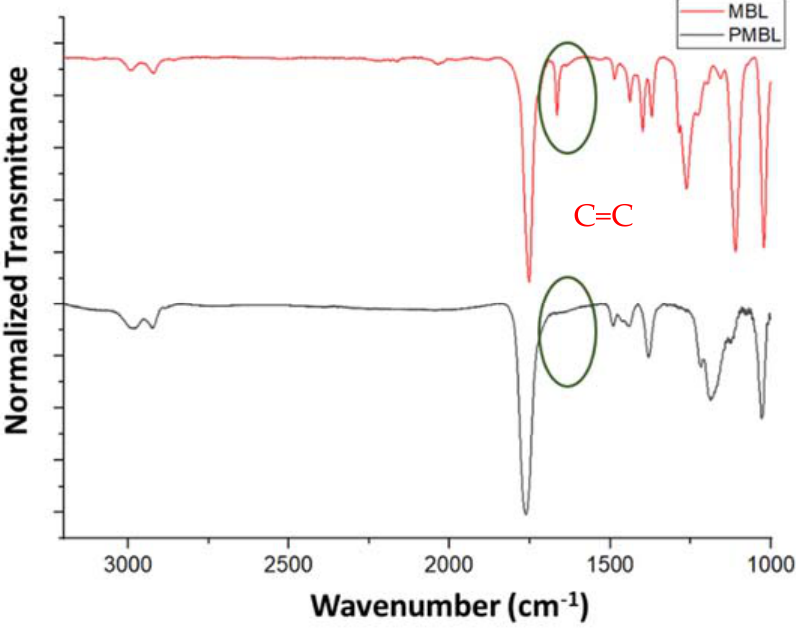
Figure 4. A comparison between FTIR spectra of α -MBL monomer and PMBL (PMBL sample (P3 in Table 1) produced by iCVD at P m / P sat = 0.52).